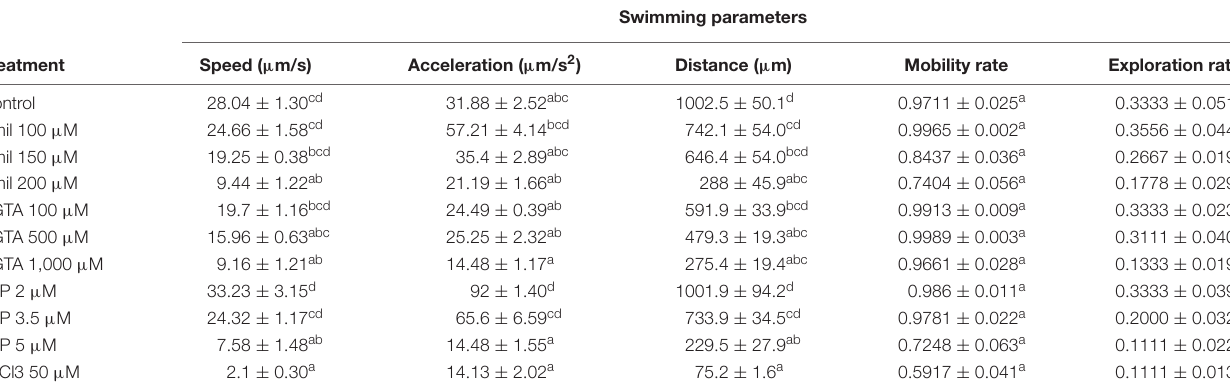
TABLE 1 | Effect of Ca 2 + inhibition treatments on zoospore swimming